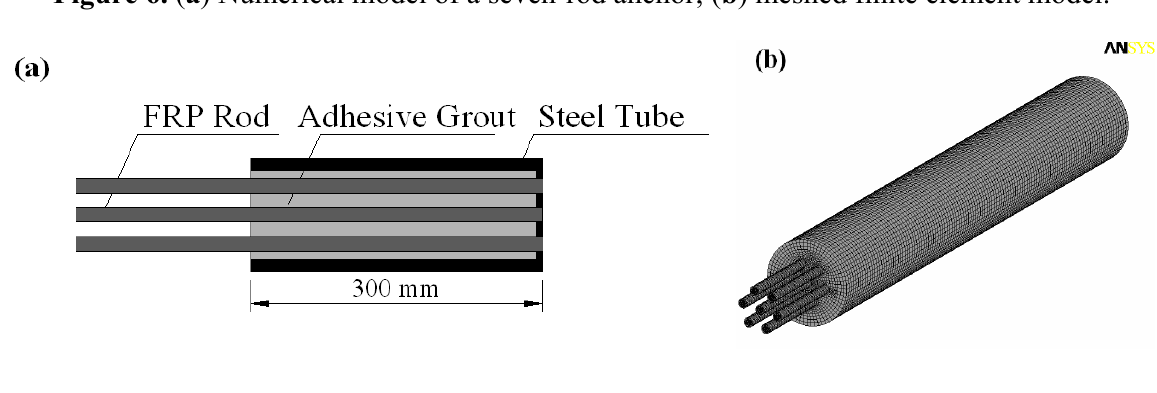
Table 3. Numerical cases for the seven-rod